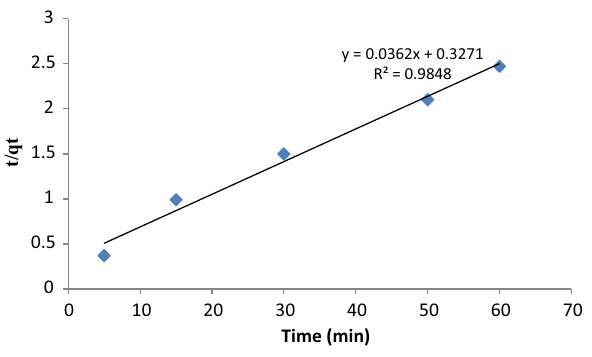
Fig. 8 Pseudo-second-order plot of Cd 2+ adsorption onto Opi